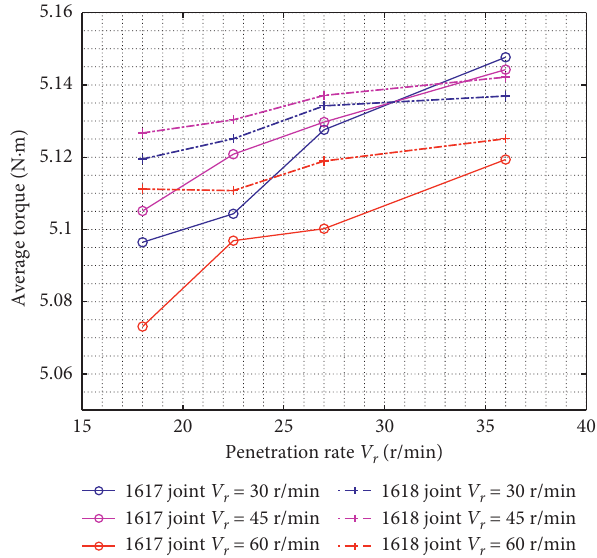
Figure 8: Variation of the average of torque changing with penetration